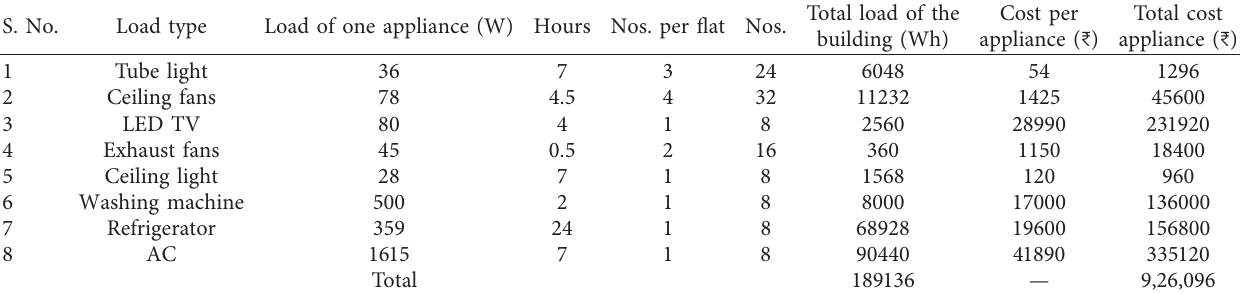
Table 1: Load calculation—conventional—1BHK.